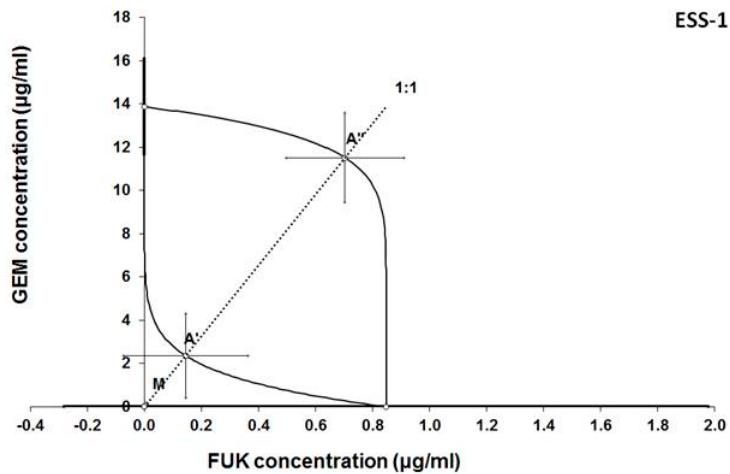
Figure 4. Isobologram showing interaction between gemcitabine (GEM) and fucoidan (FUK) with respect to their anti-proliferative effects in the cancer cell line (ESS-1) measured in vitro by the MTT assay. Although the experimentally-derived IC 50 mix value is placed below, but near to the point A’, the interaction between GEM and FUK in this cancer cell line is additive.